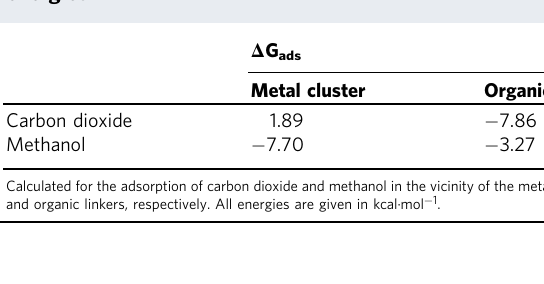
Table 1 Results from DFT + D calculations of adsorption